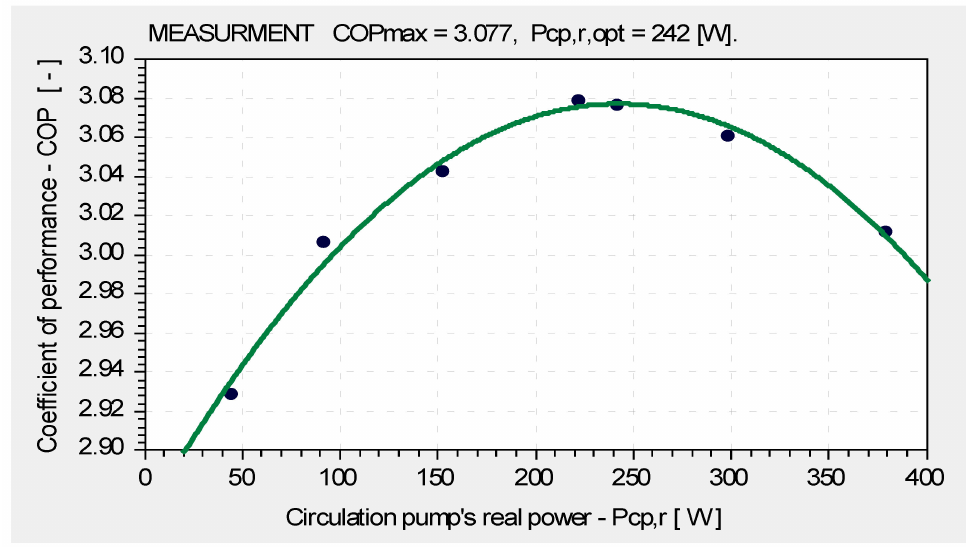
Figure 5. The measured values of the COP c and P cp , r presented in the diagram [21].